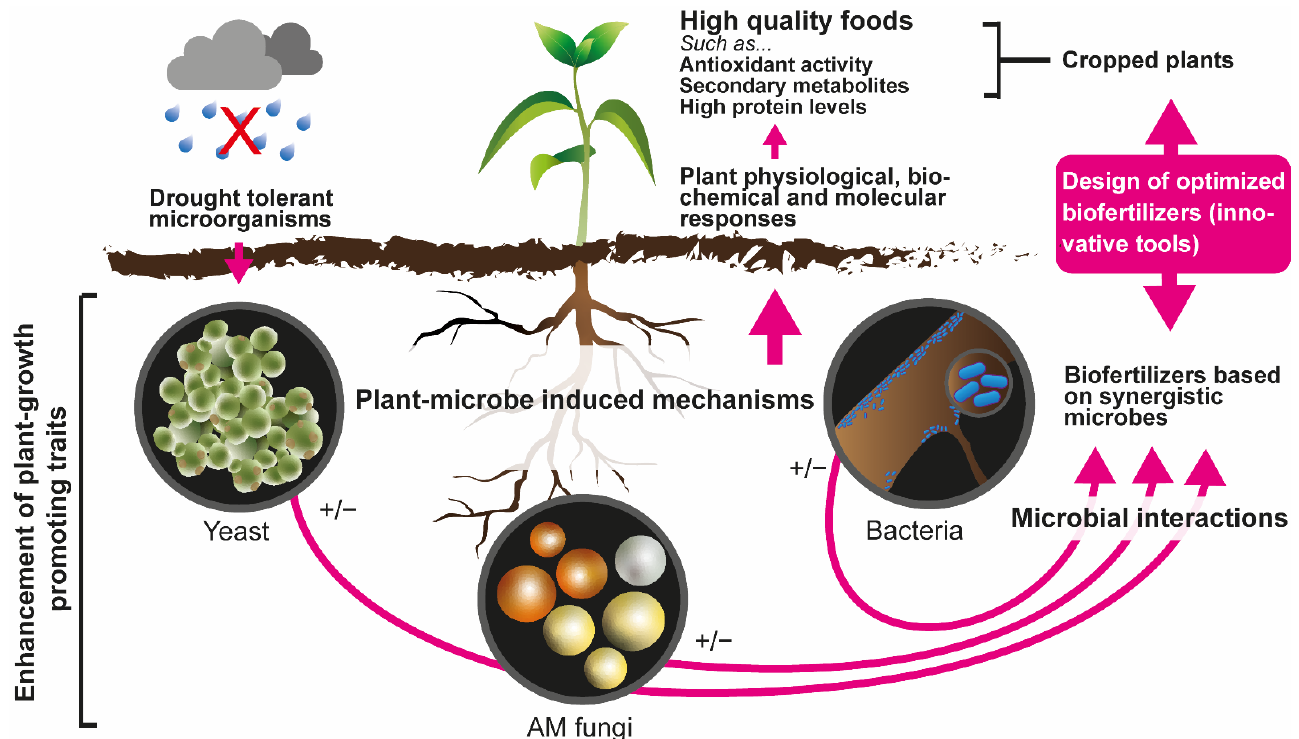
Figure 1. Generalized representation of the main effects of plant growth-promoting (PGP) traits on cropped plants under drought conditions as the basis for the design of optimized biofertilizers. Possible effects of PGP microorganisms on plants are shown with +/ − since such effects might be positive or negative.